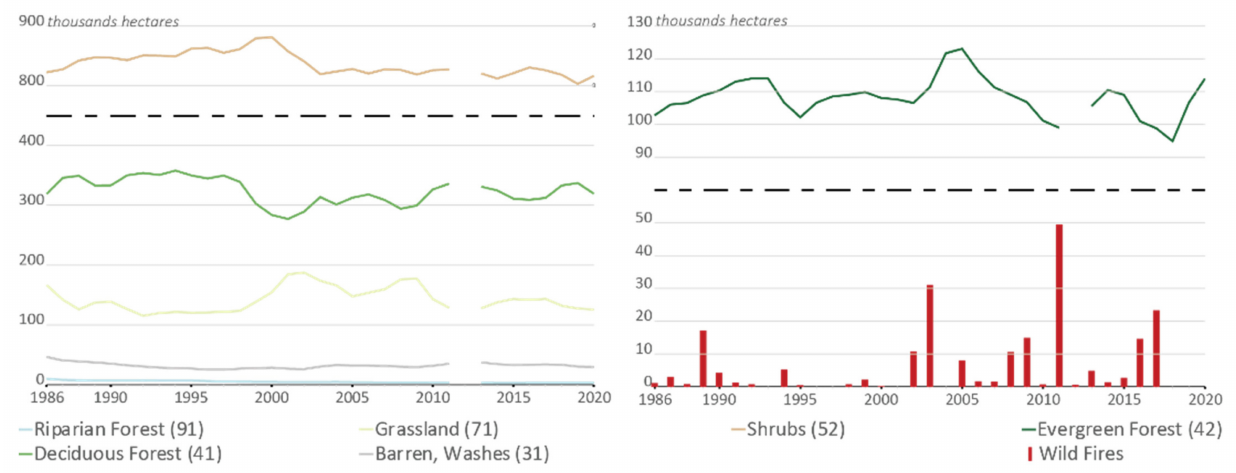
Figure 5. Natural land cover changes (1986–2020); note that the gap in the figure corresponds to the year 2012 which was not mapped. Wildfire extent is represented here [83], may be of various burn severity.